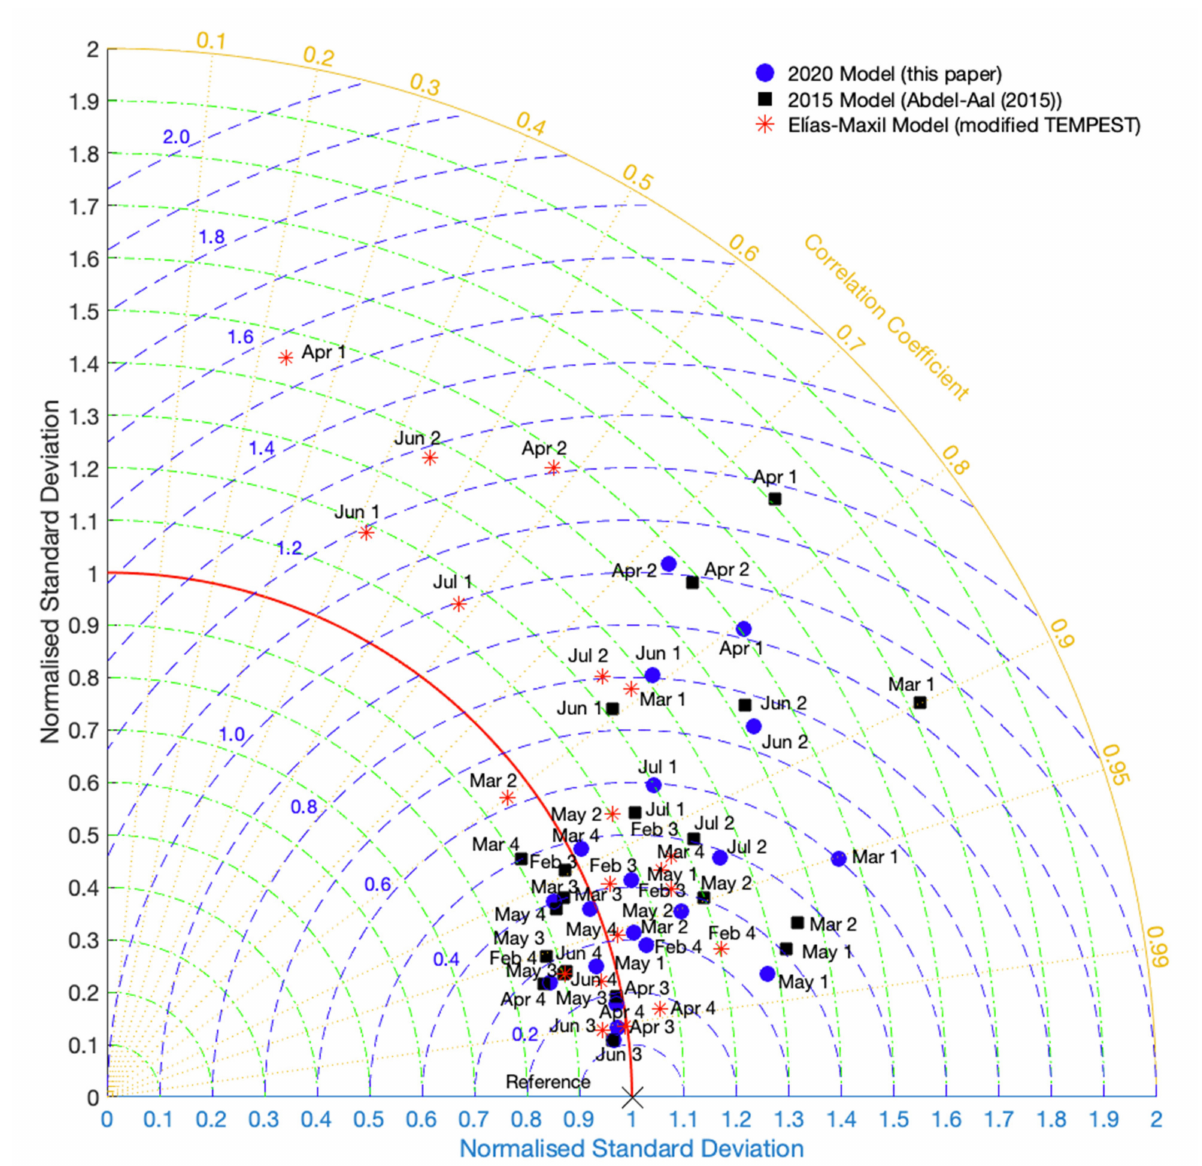
Figure 10. Taylor diagram for modelled wastewater temperatures at downstream ends at all sites using 2020, 2015 and El í as-Maxil models. 1, 2, 3 and 4 refer to model statistics from sites 1, 2, 3 and 4, respectively. The normalised centered root-mean-square errors ( ˆ CRMSE ) is proportional to the radial distance from the reference point and are represented by the blue dashed contour